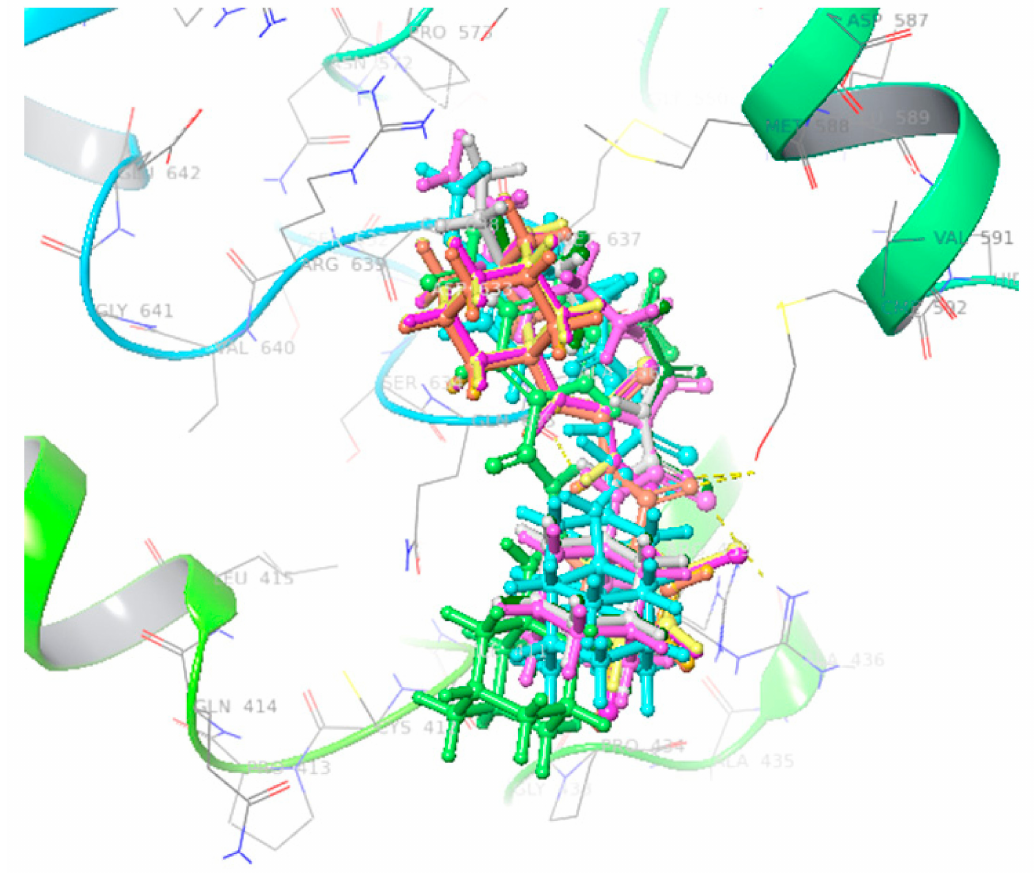
Figure 5. Docking complexes of all ligands within active region having similar